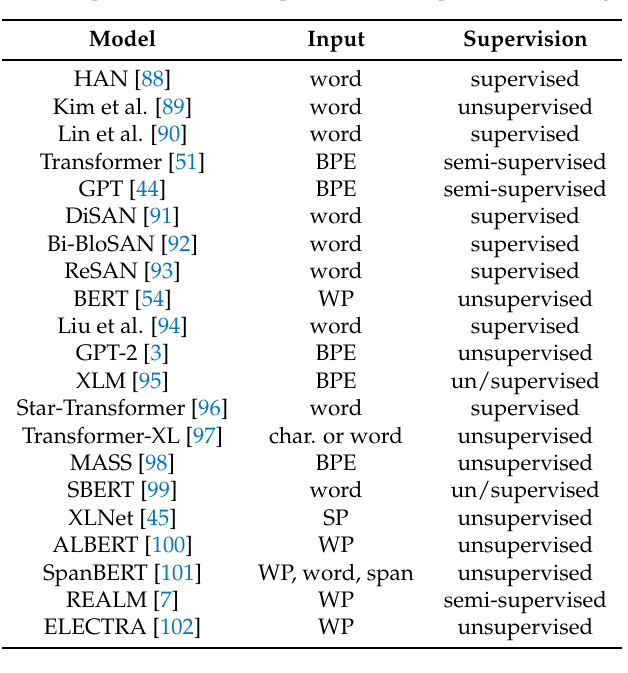
Table 5. The categorization of attention models by input level and supervision. All listed models learn sentence+ representations. BPE and WP stand for byte pair encoding and WordPiece, respectively. Un/supervised supervision represents both unsupervised and supervised